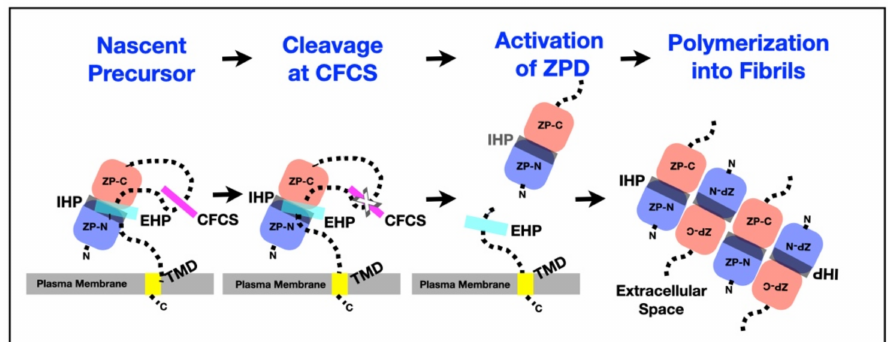
Figure 5. A general mechanism for assembly of nascent ZP proteins. In all ZPD precursor proteins, the ZPD consists of 2 subdomains, ZP-N (blue) and ZP-C (pink). The subdomains are followed by a CTP that contains a CFCS (magenta), an EHP (cyan), and a TMD (yellow). Precursors do not polymerize within the cell, either as a result of direct interaction between the EHP and IHP (gray) or because they adopt a conformation dependent on the presence of both hydrophobic patches. Proteolytic processing at the CFCS (marked by a cross) leads to dissociation of mature proteins from the EHP and activation of the ZPD for polymerization into fibrils and matrix.